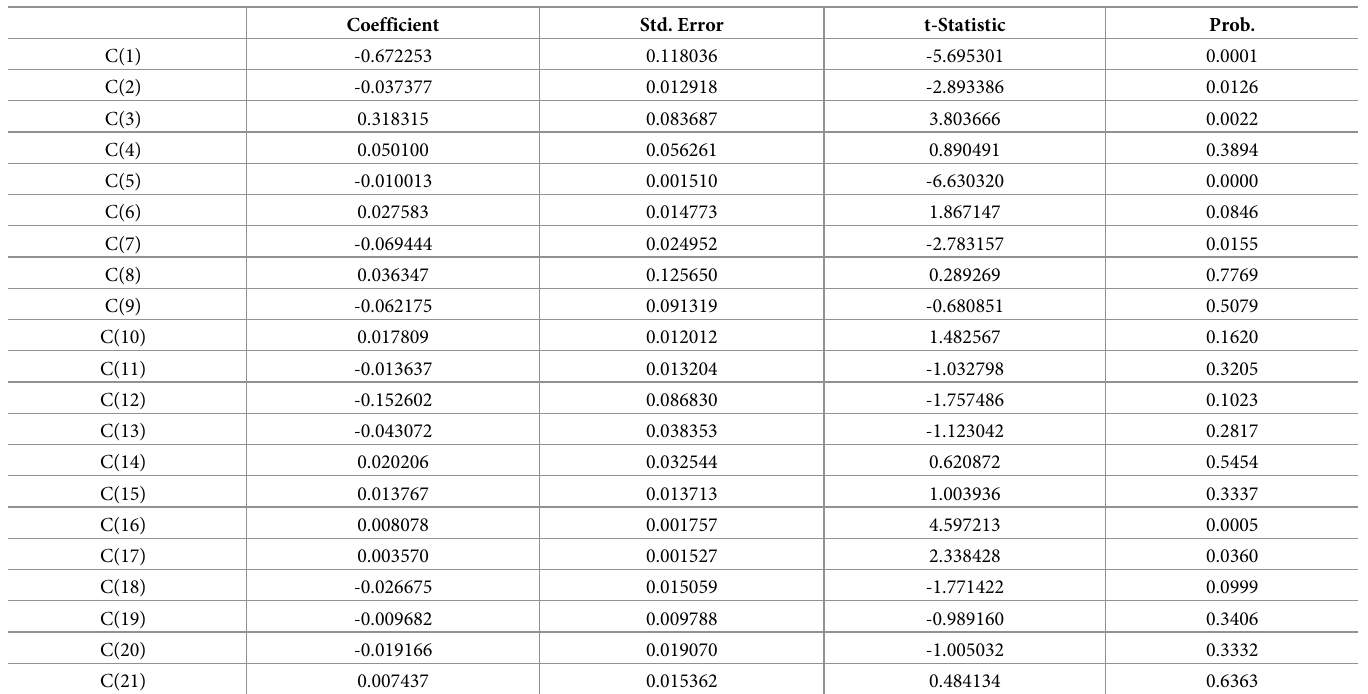
Table 5. Probability values for system